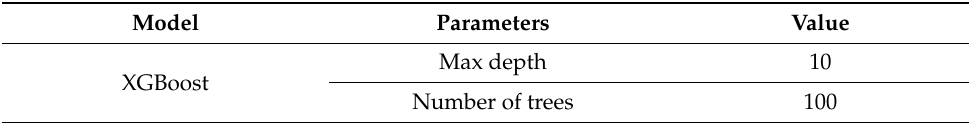
Table 3. Hyperparameters of XGBoost